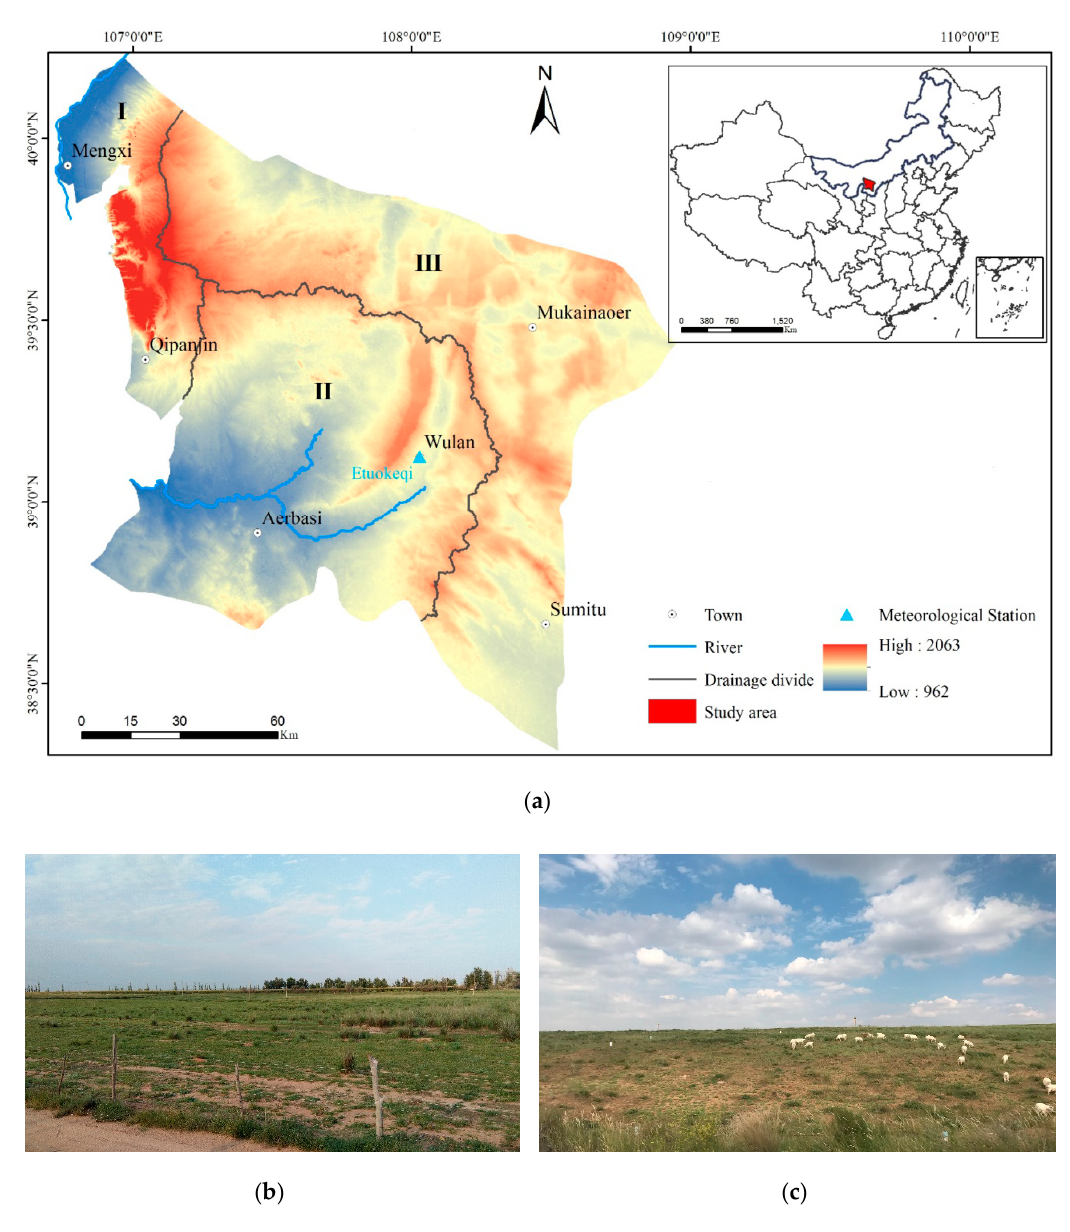
Figure 1. ( a ) Location of study area and division of water resource regionalization; ( b ) The rangeland in pastoral area of OtogBanner; ( c ) The grazing behavior in pastoral area of OtogBanner.